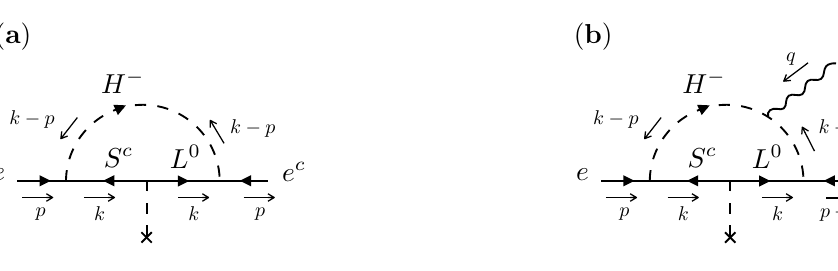
Figure 1 . One-loop diagrams providing the (a priori) leading contribution to (a) the mass, and (b) electromagnetic dipole moments of charged SM leptons in the model of eq. (2.6) with Y Both diagrams are proportional to the combination of couplings Y